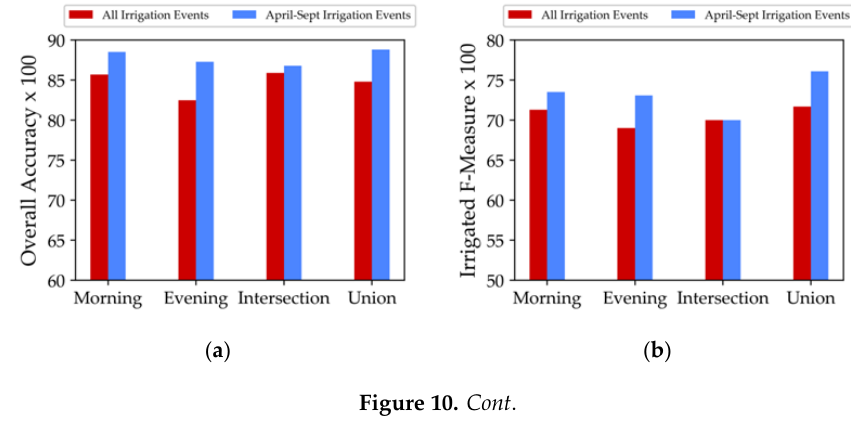
Table 3. The values of the overall accuracy and F-measure obtained for classification of irrigated and non-irrigated plots using the detected irrigation points for four different